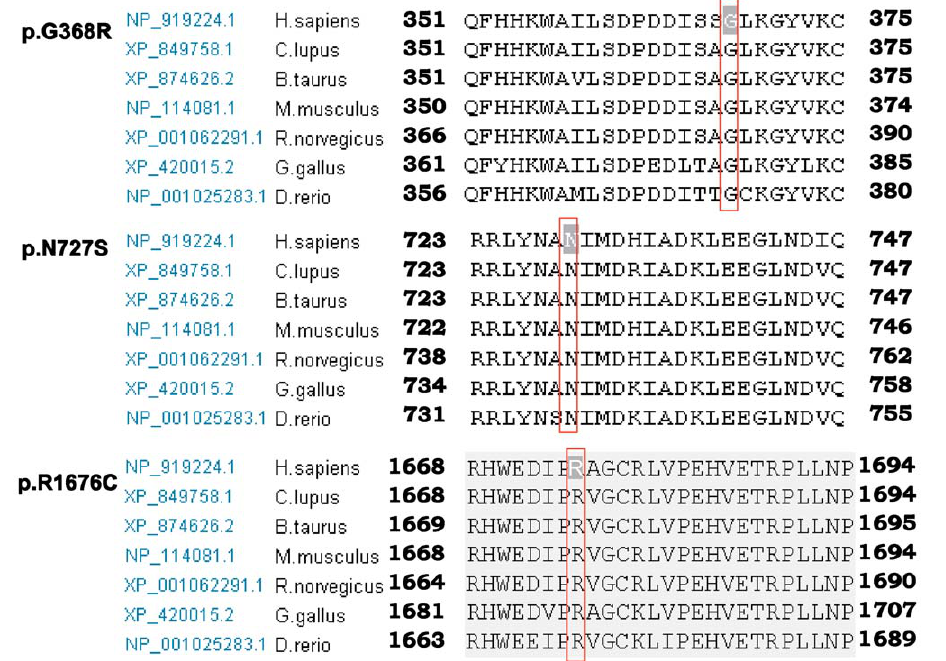
Figure 4. Evolutionary conservation of the residue altered in novel OTOF mutations. The ClustalW alignment result of the long isoform of otoferlin among different organisms, including human, dog, cattle, mouse, rat, bird and fish. The locations of mutated amino acids are boxed and highlight in inversed color.